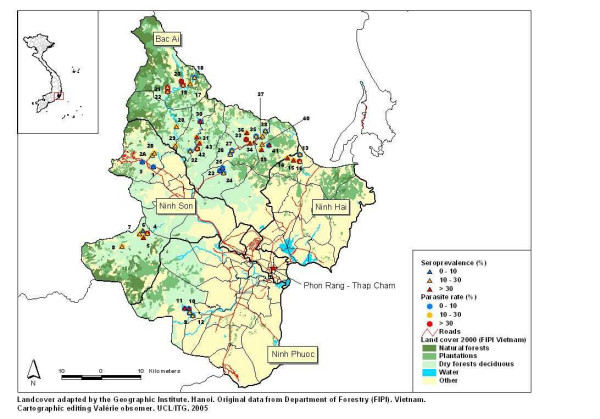
Land-cover map Ninh Thuan province with parasite rate and malaria seroprevalence for the 43 study villages-Nov.2003 (see details, Table 1).